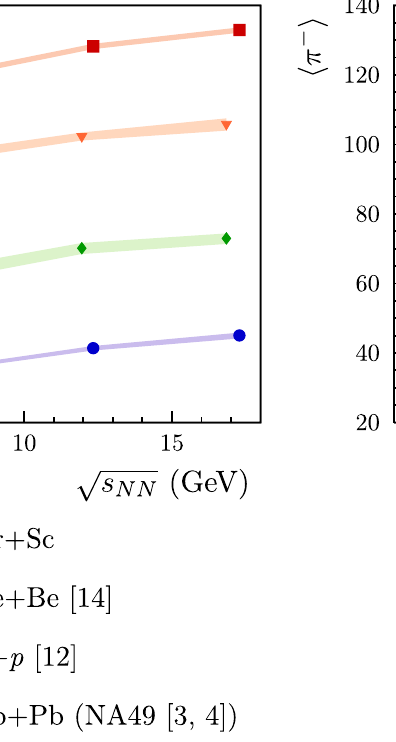
systematic uncertainties are indicated by shaded bands. Right: Compar- ison of the results for Ar+Sc collisions as shown in the left plot with Epos , U r qmd and Hijing model calculations (black curves)